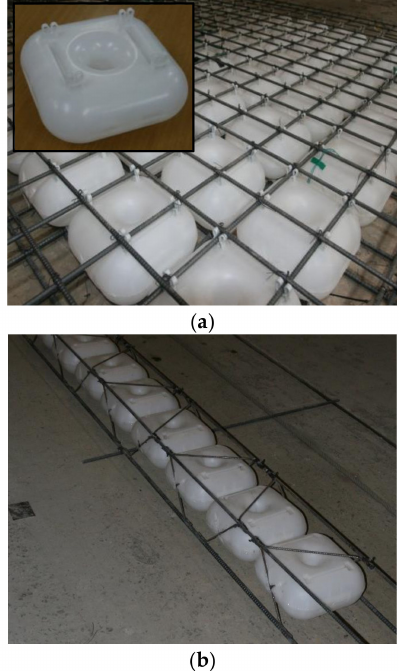
Figure 8. Fixing methods of the donut-type voided slab: ( a ) spacer-type fixing method; ( b ) merged- type fixing